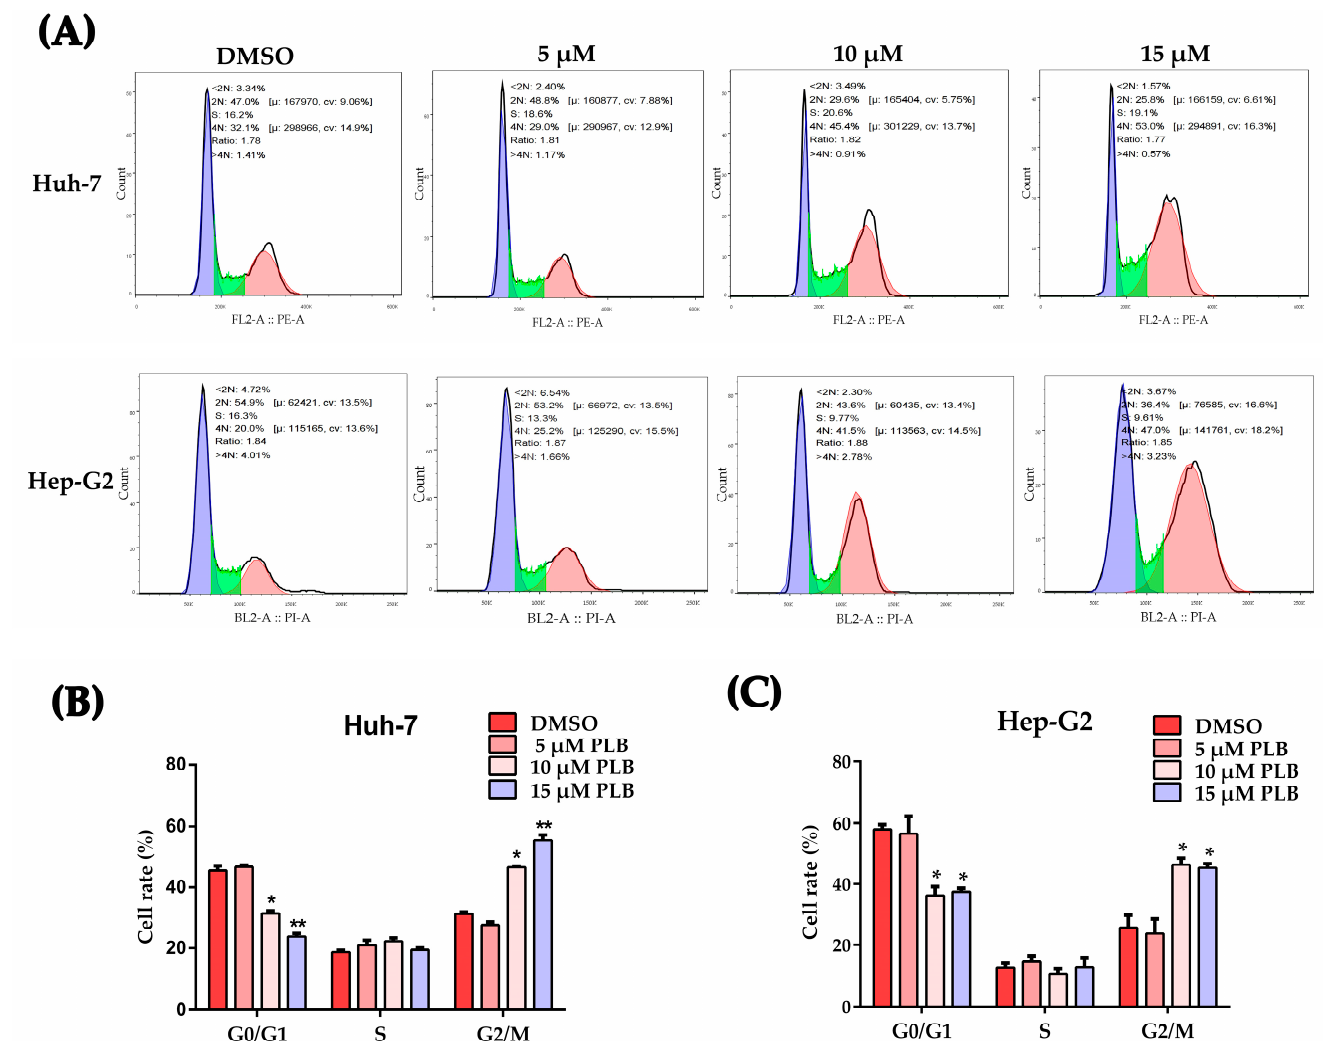
Figure 2. Plumbagin-triggered G2/M cell cycle arrest in HCC cells. ( A ) Representative images from the flow cytometry after treatment by plumbagin for 12 h. The colors purple, green and pink represent G0/G1, S and G2/M phase, respectively. ( B , C ) Percentage of the cells at different cell cycle stage was analyzed based on the flow cytometry results. * p < 0.05, ** p < 0.01 compared to the DMSO group; three independent experiments were